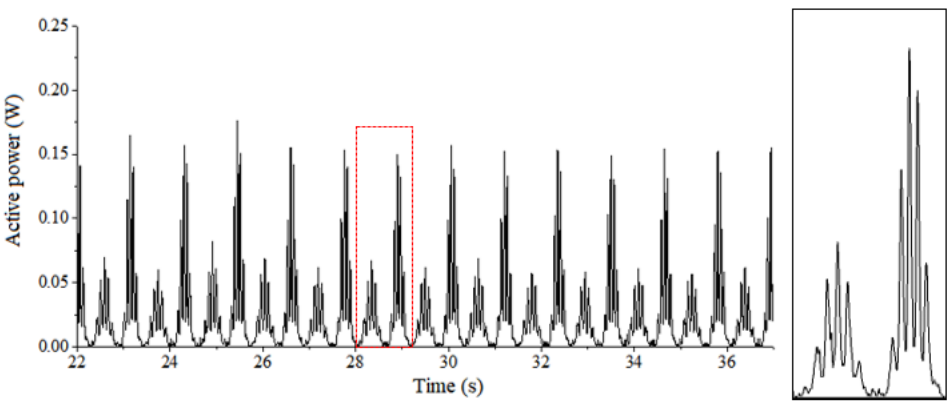
Figure 20. Active power diagram (including the zoom-up of the enclosed region between 28.0 s and 29.2 s) under traveling waves of T / T p = 1.0, h = 0.6 m.